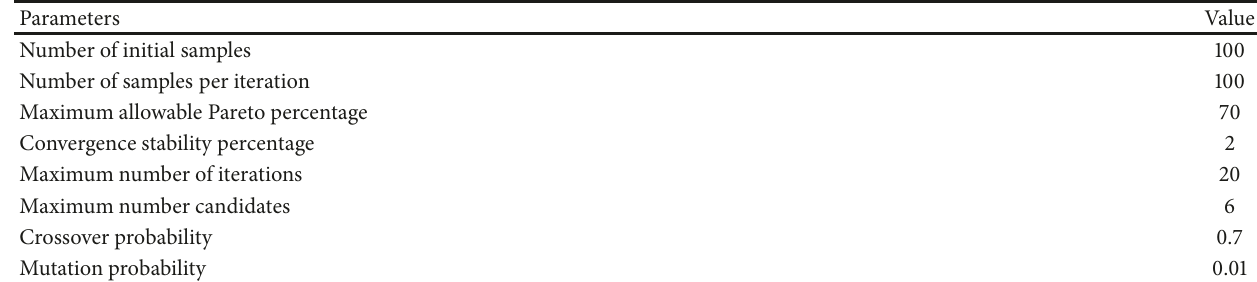
Table 2: Controllable parameters for MOGA